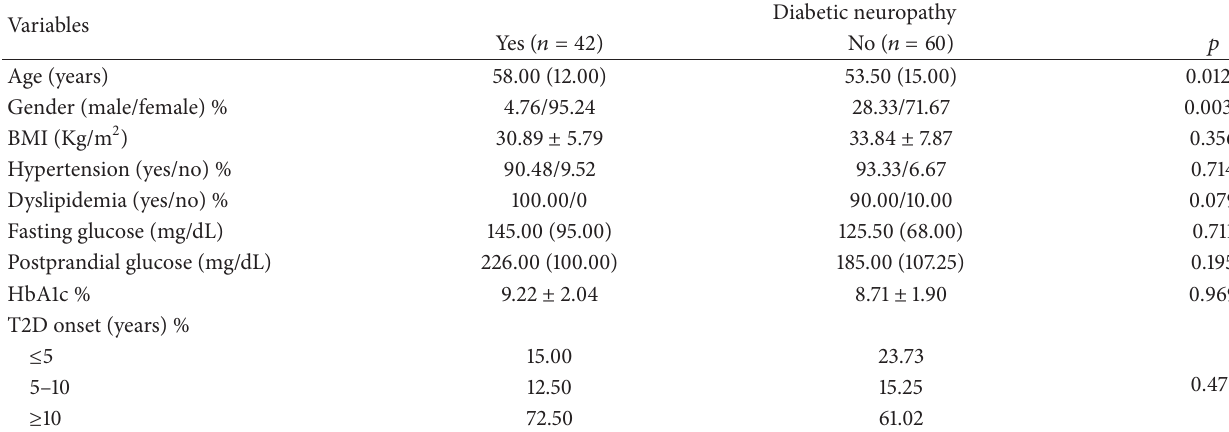
Table 3: Clinical and laboratorial characteristics in T2D patients considering neuropathy